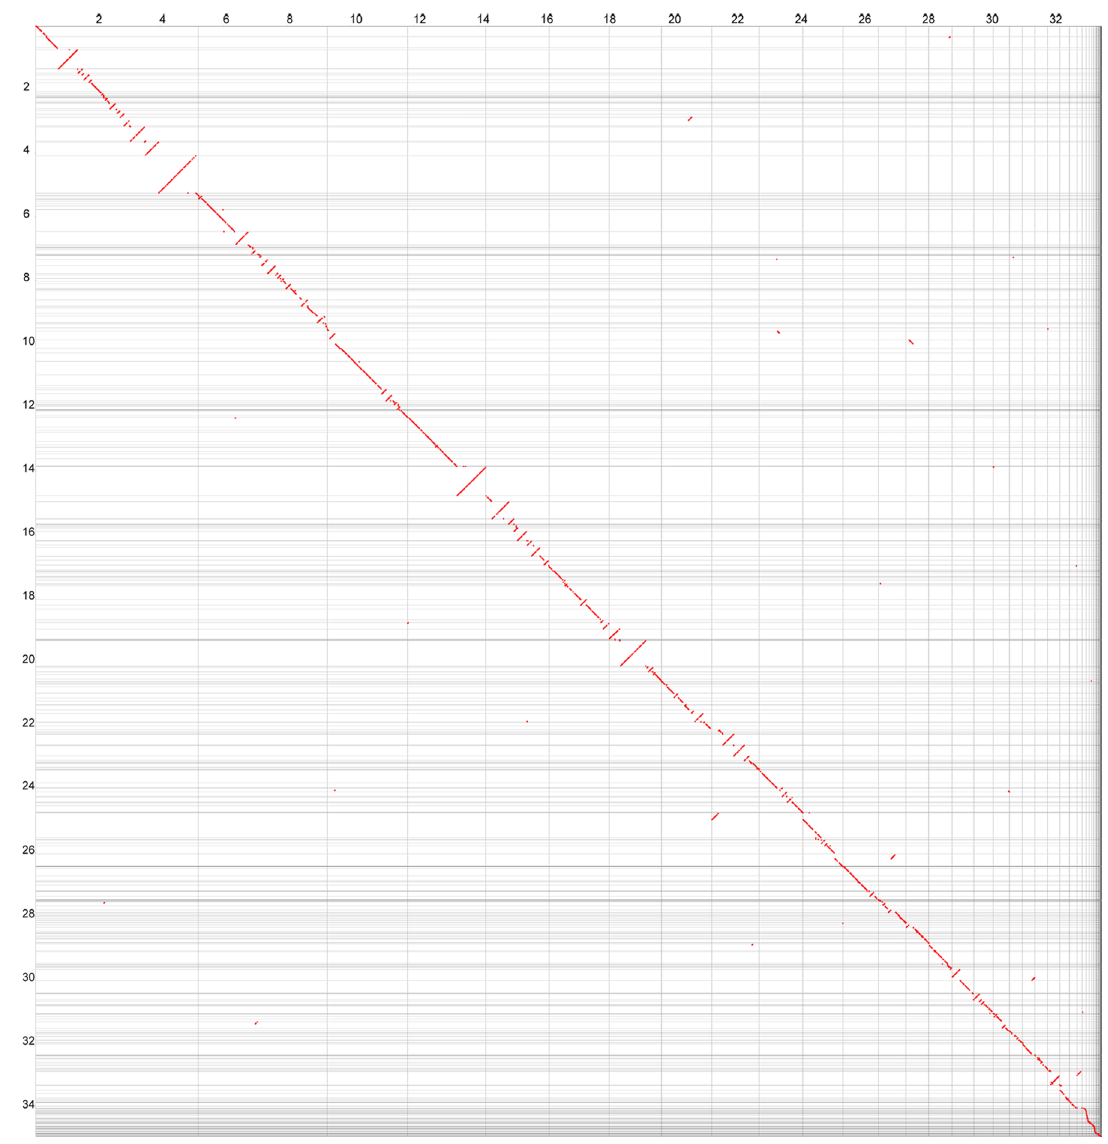
Fig 4. Synteny dotplot of A . longipes cx1 (y-axis) and A . alternata cx2 (x-axis). Regions of homology are plotted as diagonal